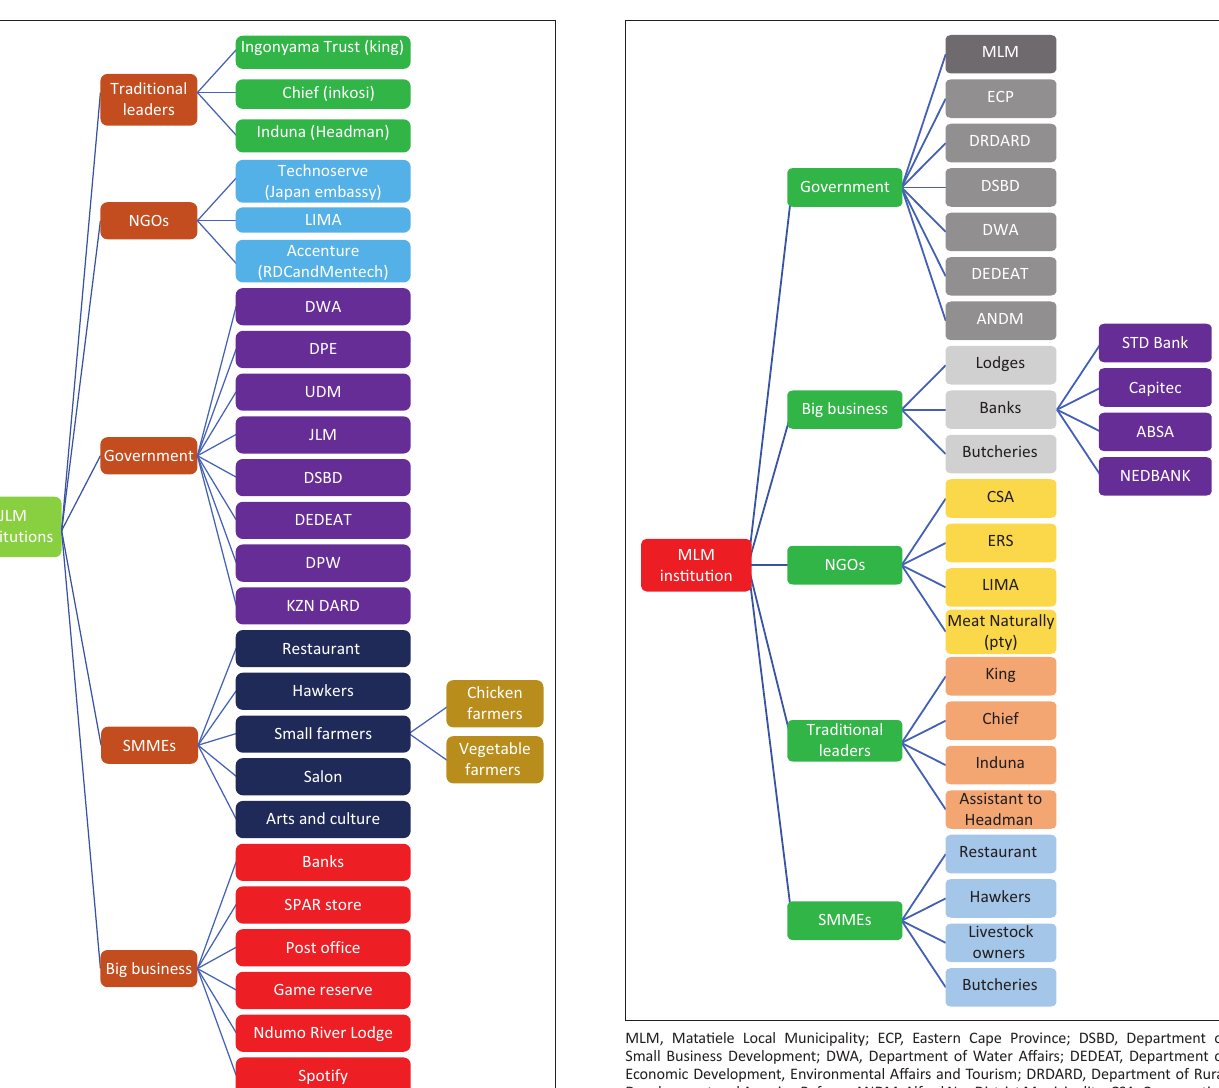
FIGURE 2: Summary of Jozini Local municipality’s small, medium and micro enterprises’ social and institutional networks.